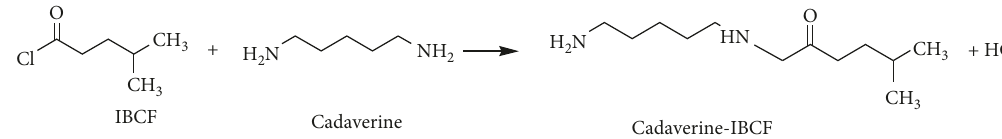
Figure 3: Reaction process for cadaverine derivatized by isobutyl chloroformate